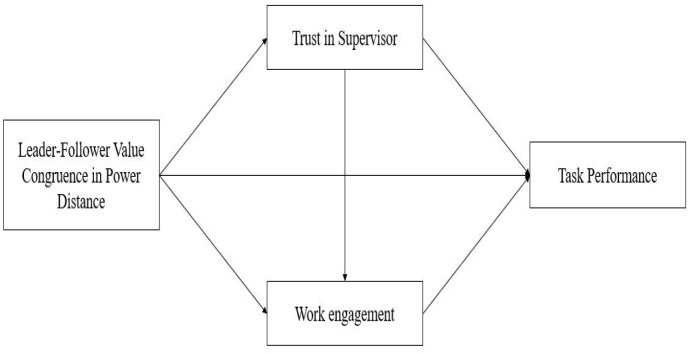
Conceptual model.